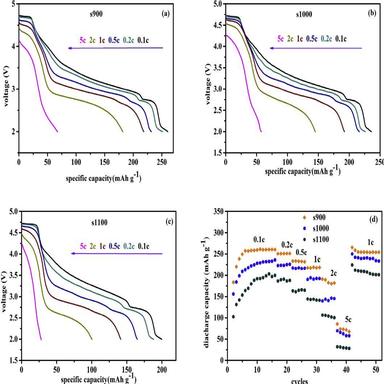
Voltage profiles of (a) s900, (b) s1000, and (c) s1100 samples at different C-rates. (d) Cycling stability curves of the s900, s1000, and s1100 samples at different C-rates over a 2.0e4.8 V voltage window.